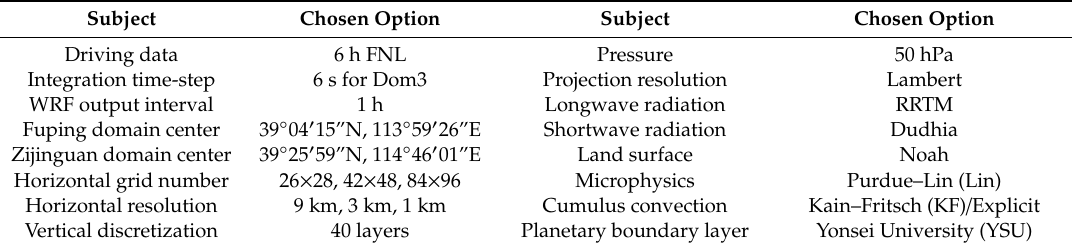
Table 2. Configurations of the WRF